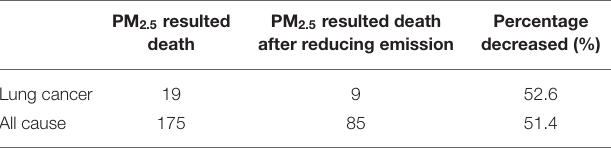
TABLE 5 | Comparison between PM 2.5 resulted death after reducing the emission by half in December 2019. PM 2.5 resulted